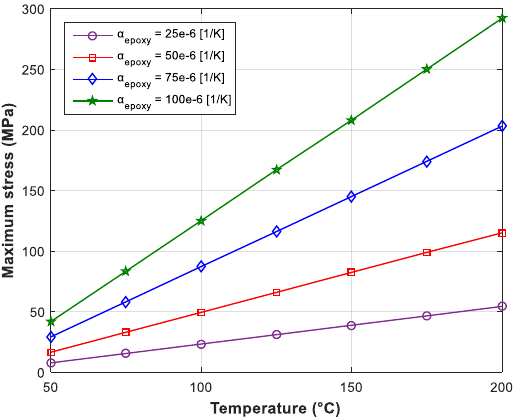
Figure 8. Maximum stress in the copper wire in the middle of the winding, as a function of temperature, for different thermal expansion coefficients of epoxy.